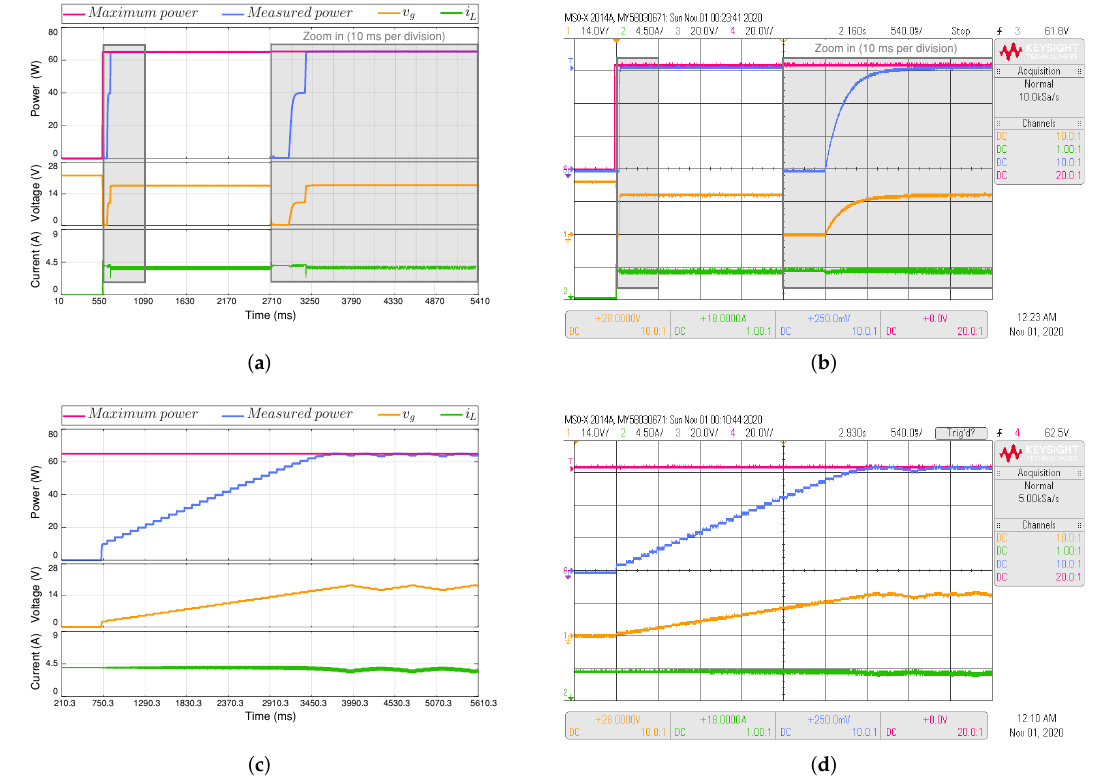
Figure 8. Simulated ( a , c ) and experimental ( b , d ) dynamic behavior of the MPPT algorithms during system start-up with an irradiance of 1000 W/m 2 and an output voltage V o = 36 V. The proposed MPPT algorithm (top) is compared with perturb and observe (P&O)-based MPPT algorithm (bottom). CH1: v g (14 V/div), CH2: i L (4.5 A/div), CH3: Maximum power (20 W/div), CH4: Measured power (20 W/div) and a time base of 540 ms and 10 ms in the zoom-in